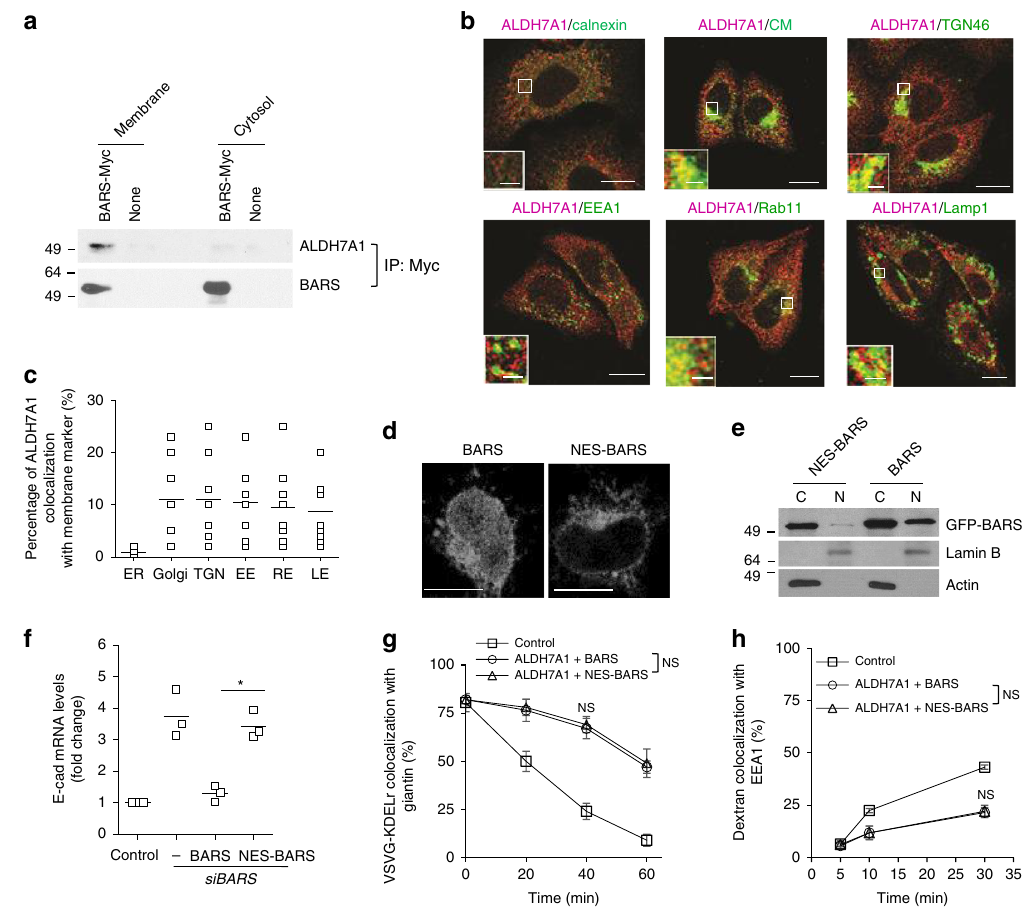
Fig. 4 ALDH7A1 targets the transport function of BARS. Source data are provided as a Source Data fi le. a HeLa cells were subjected to subcellular fractionation to obtain total membrane vs. cytosol fractions. Both fractions were then subjected to co-immunoprecipitation experiments to detect the association of ALDH7A1 with BARS; n = 2 independent experiments with a representative result shown. b Confocal microscopy was performed to detect the colocalization of ALDH7A1 with different organelle markers; scale bar, 10 µ m (2 µ m in inset); n = 3 independent experiments with representative images shown. c Quantitation of the colocalization results above; n = 3 independent experiments with ten fi elds of cells examined in each experiment. d HeLa cells were transfected with GFP-tagged NES-BARS followed by confocal imaging across the nuclear portion of the cell; scale bar, 10 µ m; n = 2 independent experiments with a representative image shown. e HeLa cells were fractionated into nuclear vs. cytoplasmic fractions, followed by immunoblotting for proteins as indicated. Lamin B serves as a marker of the nucleus, while actin serves as a marker of the cytoplasm; n = 2 independent experiments with a representative result shown. f HeLa cells were treated as indicated, and then the mRNA level of E-cadherin, which has been a model transcript for studies on transcription repression by BARS/CtBP, is quanti fi ed; n = 3 independent experiments. g HeLa cells were treated as indicated, and then colocalization of VSVG-KDELR with a cis -Golgi marker (giantin) coupled with kinetic analysis was performed. Mean with standard deviation is shown; * p < 0.05, paired two-tailed Student ’ s t -test; n = 3 independent experiments. h HeLa cells were treated as indicated, and then colocalization of dextran with an early endosome marker (EEA1) coupled with kinetic analysis was performed. Mean with standard deviation is shown; * p < 0.05, paired